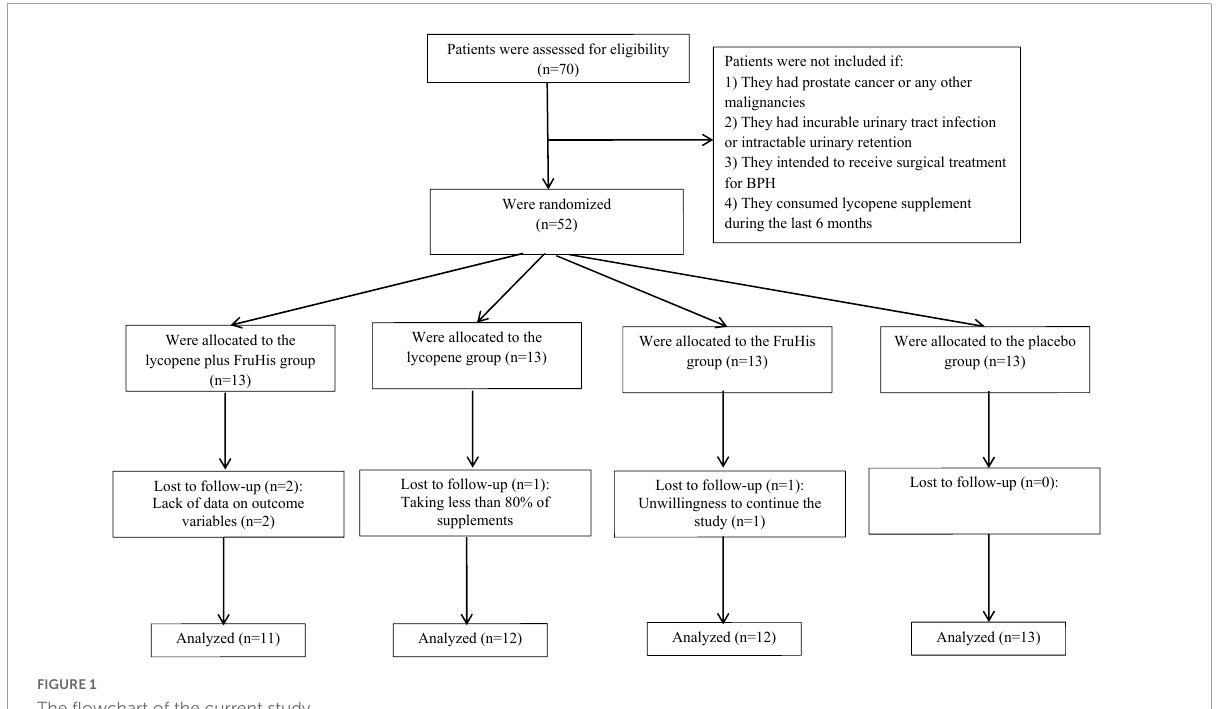
FIGURE1 The flowchart of the current